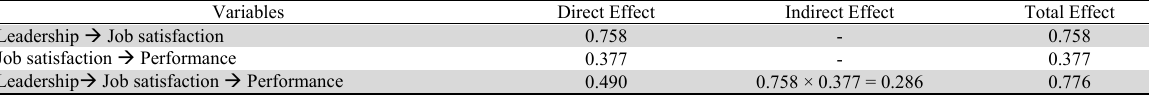
Direct Effect, Indirect Effect, and Total